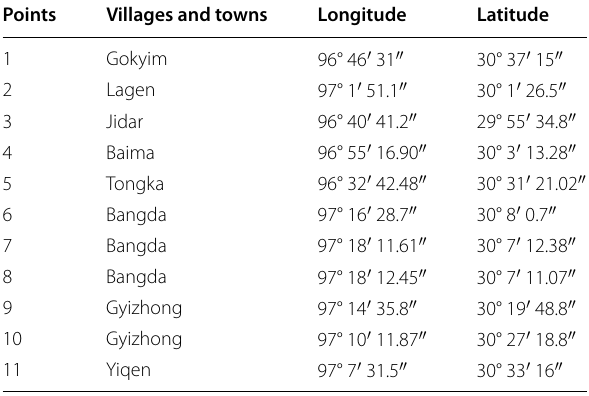
Table 3 Data of disaster points not located in susceptibility areas Points Villages and